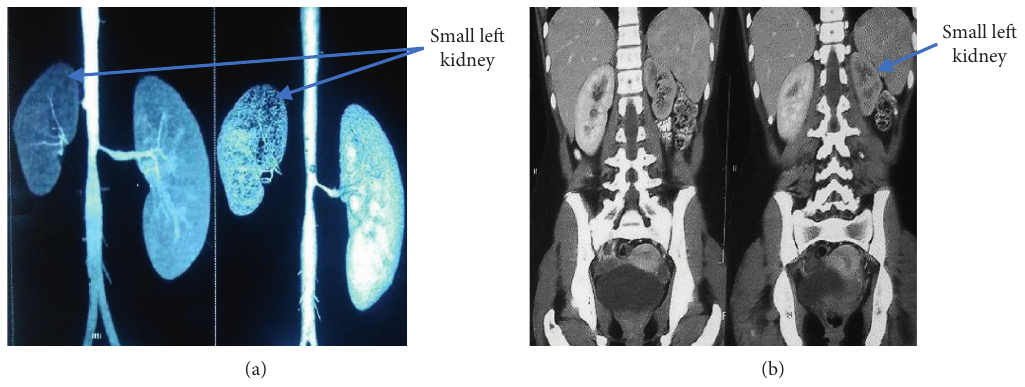
Figure 4: : CTA showing small left